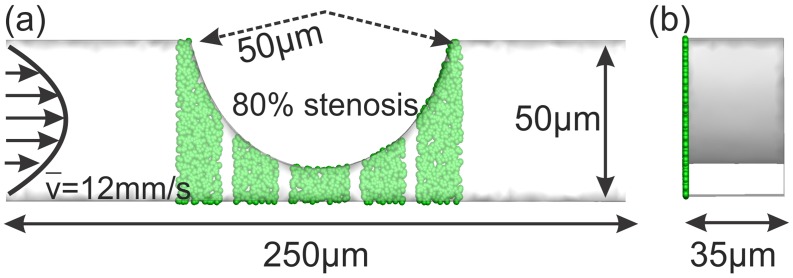
Schematic of a microchannel with constriction representing a stenosis and used for modeling platelet aggregation at high shear rate.(a) view normal to the flow direction; (b) side view along the flow direction; green particles are seeded uniformly on the left wall to represent vWF-coated regions similar to the experimental device in Westein et
al. [14].